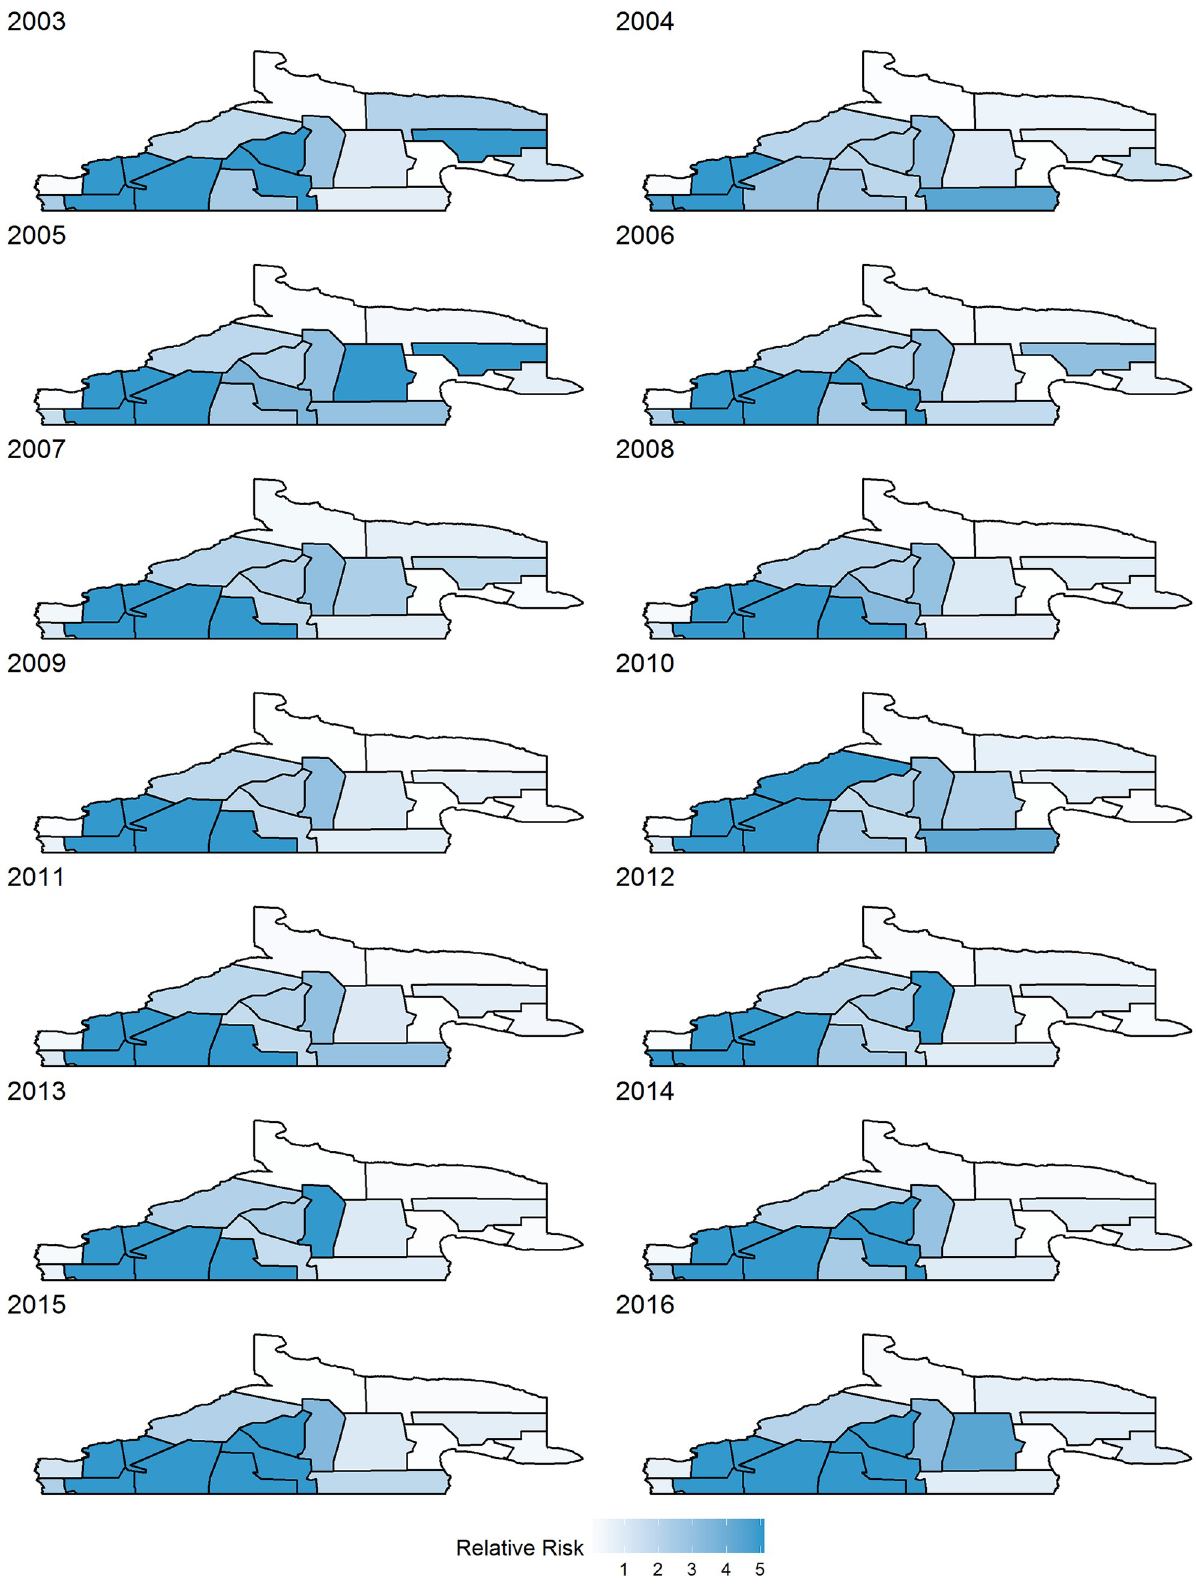
Fig 6. Model 1.1a –Posterior mean relative risks—Surveillance Data. https://doi.org/10.1371/journal.pntd.0008545.g006 PLOS NeglectedTropical Diseases | https://doi.org/10.1371/journal.pntd.0008545 August 25,